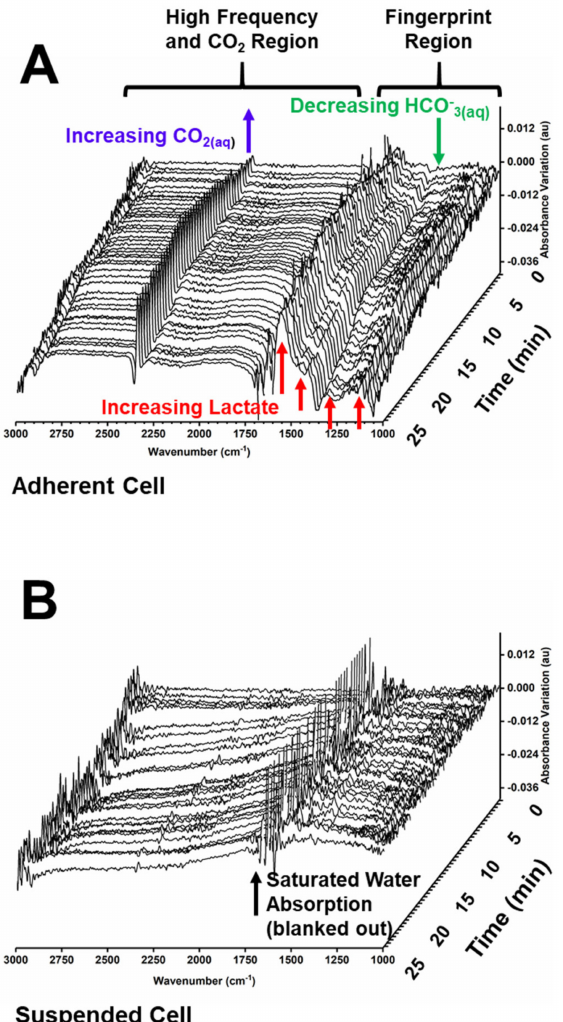
Figure 1. Spectral variations of single adherent and suspended cells over 25 min. ( A ). Single Adherent Cell. The brackets define the fingerprint spectral region and the high frequency region. The arrows show the increasing absorption bands from lactate (red) and CO 2(aq) (blue) and the decreasing absorption band from HCO 3 − (aq) (green). ( B ). Single Suspended Cell. The arrow shows the position of the saturated absorption band from water, dominated by noise (points removed from both A and B for